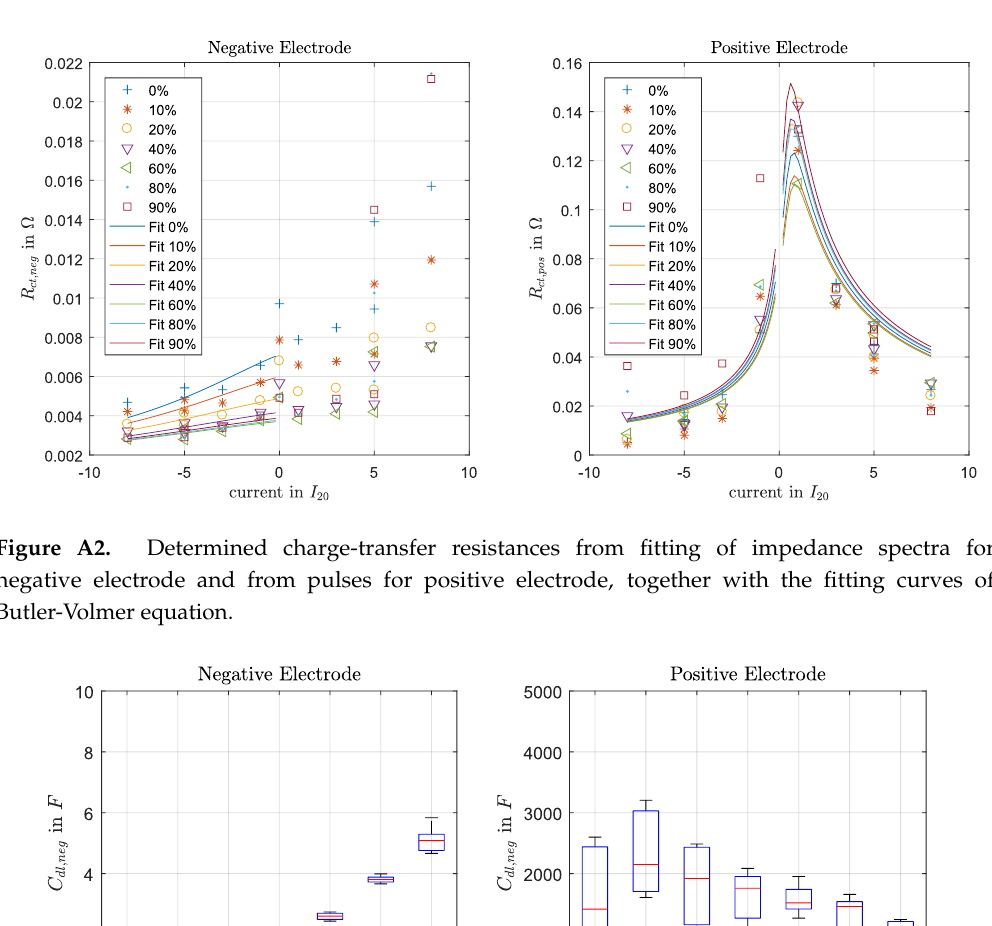
Figure A1. Determined ohmic resistance values from fitting of impedance spectra measured with discharging DC-currents over SoC.